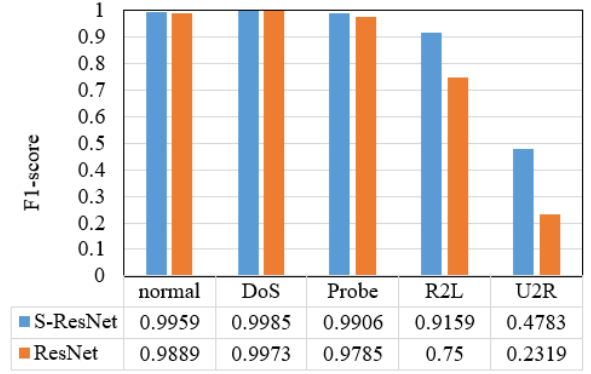
Figure 12. The F1-score results of the two IDSs for each category.